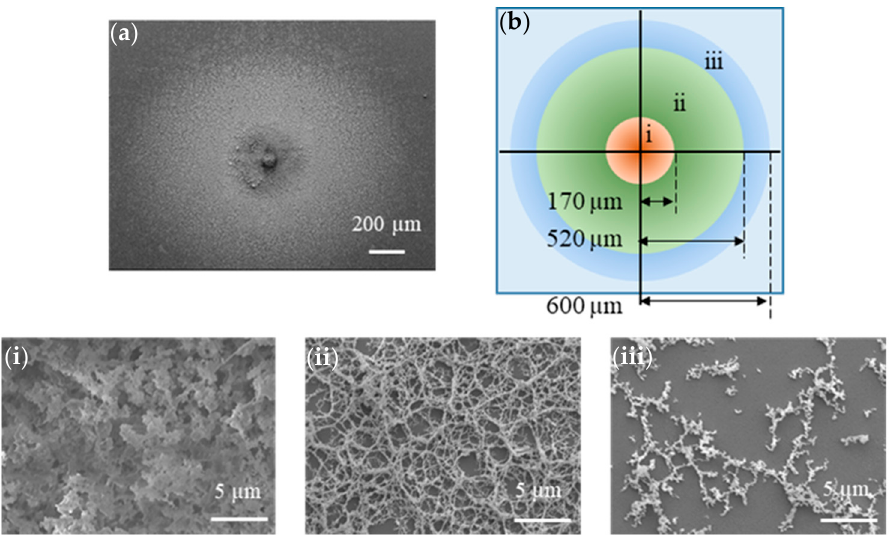
Figure 6. ( a ) Overall SEM image of deposited NPs on the glass and ( b ) a schematic of the NP-distributed areas. ( i – iii ) Enlarged SEM images corresponding to NPs deposited in areas i–iii in subfigure (b).